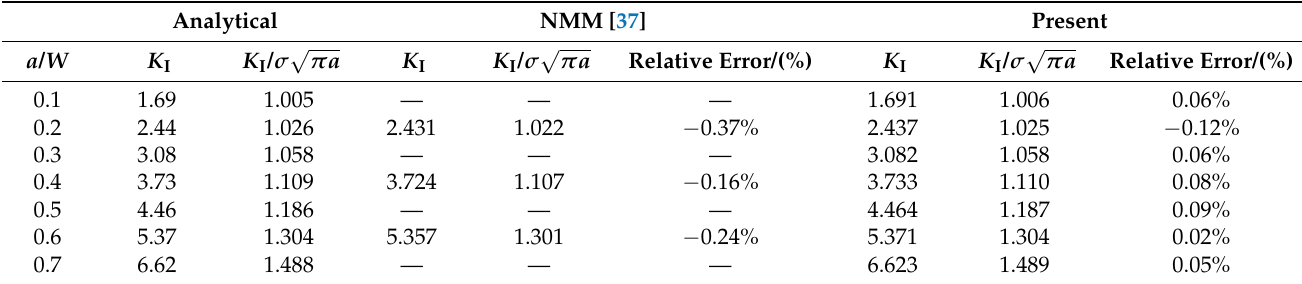
Table 2. SIFs K I ( MPa · m 1/2 ) for central straight crack plate.